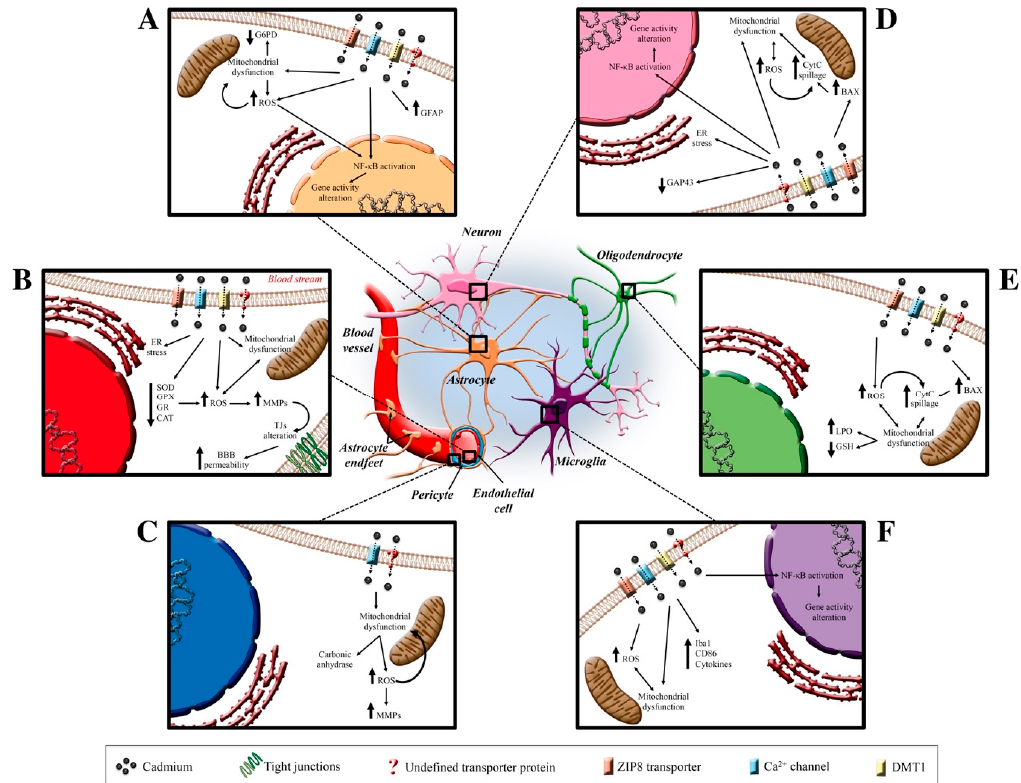
Figure 2. Cd effects on neurovascular unit. In the center of the figure, the CNS protagonists are illustrated who are the target of Cd-induced neurotoxicity. In Insert A (top left), the putative channels and transporters through which Cd enters the astrocytic cells are reported (ZIP8 transporters, Ca 2+ channels, DMT1, and undefined transporter). Once inside, Cd elicits ROS production that causes a mitochondrial disfunction and, in turn, induces the NF- κ B activation and a consequent gene transcription alteration. Insert B (middle left) shows the known Cd-dependent molecular pathway involving a decrease in antioxidant systems and ER stress that induces an MMP alteration and a TJs disassembly-dependent BBB alteration. Insert C (lower left) shows the Cd-dependent alterations in pericytes. Insert D–F (on the right) summarizes the Cd-dependent alterations that involve neuron, oligodendrocyte and microglia, respectively. Abbreviations: BAX (Bcl-2 associated protein); BBB (blood-brain barrier); CAT (catalase); CD86 (cluster of differentiation 86); CytC (cytochrome C); ER (endoplasmic reticulum); G6PD (glucose-6-phosphate dehydrogenase); GAP43 (growth associated protein 43); GFAP (glial fibrillary associated protein); GPX (glutathione peroxidase); GR (glutathione reductase); GSH (glutathione); Iba1 (ionized calcium-binding adapter molecule 1); LPO (lipid peroxidation); MMPs (matrix metalloprotease); NF- κ B (nuclear factor kappa-light-chain-enhancer of activated B cells); ROS (reactive oxygen species); SOD (superoxide dismutase); TJs (tight junctions). Funding: This research was funded by Cassa di Risparmio di Firenze to Matteo Becatti (BECCRF170849). Conflicts of Interest: The authors declare no conflict of interest.